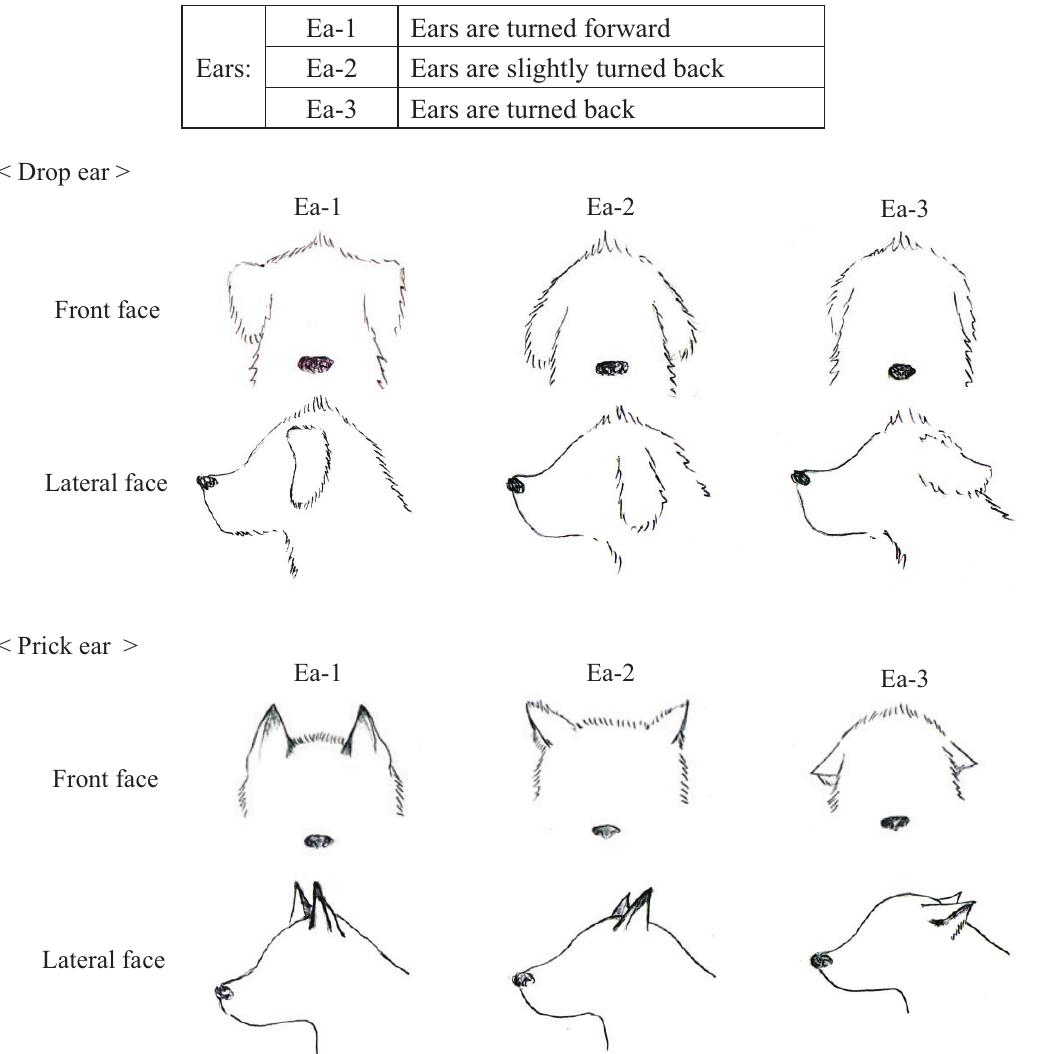
Figure 3. Categories of ear (Ea) appearances in dogs during their